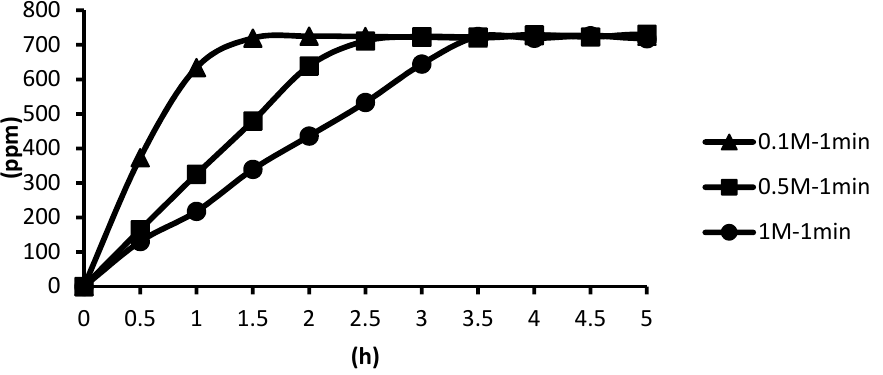
Figure 18. The effect of CaCl 2 concentration (cross-linking time of one minute) on releasing of tea tree essential oil from alginate/tea tree essential oil microcapsules in the hot spring water.